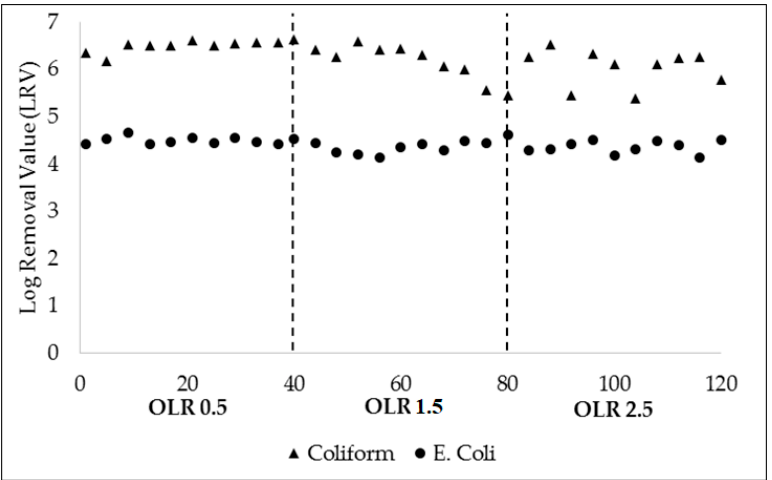
Figure 8. Removal efficiencies of coliform and E. Coli.